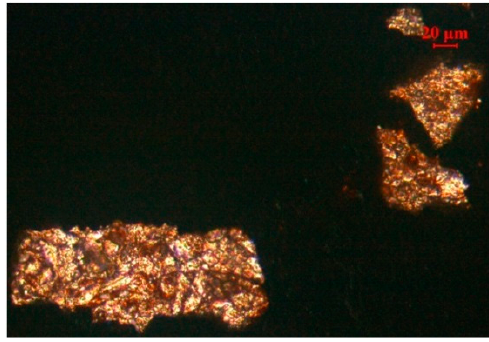
Figure 3. Collophanite particles under the polarizing microscope.